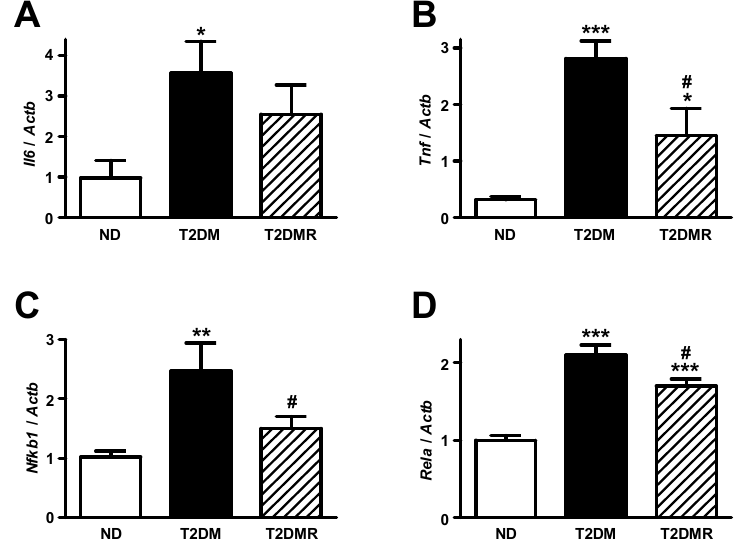
Figure 5. Resveratrol attenuated pro-inflammatory cytokine expression in epididymal adipose tissue of T2DM mice. Interleukin 6 ( Il6 , A ); tumour necrosis factor ( Tnf , B ); nuclear factor kappa B subunit 1 ( Nfkb1 , C ); and RELA proto-oncogene NF- κ B subunit ( Rela , D ) mRNAs were measured in epididymal adipose tissue of non-diabetic (ND), type 2 diabetic (T2DM) and resveratrol-treated type 2 diabetic (T2DMR) mice. All target mRNAs were normalized by Actb mRNA (actin beta). Data are expressed as mean ± SEM of seven animals, and were analysed by one-way ANOVA with the Newman-Keuls post-test. * p < 0.05, ** p < 0.01 and *** p < 0.001 vs. ND; # p < 0.05 vs. T2DM.